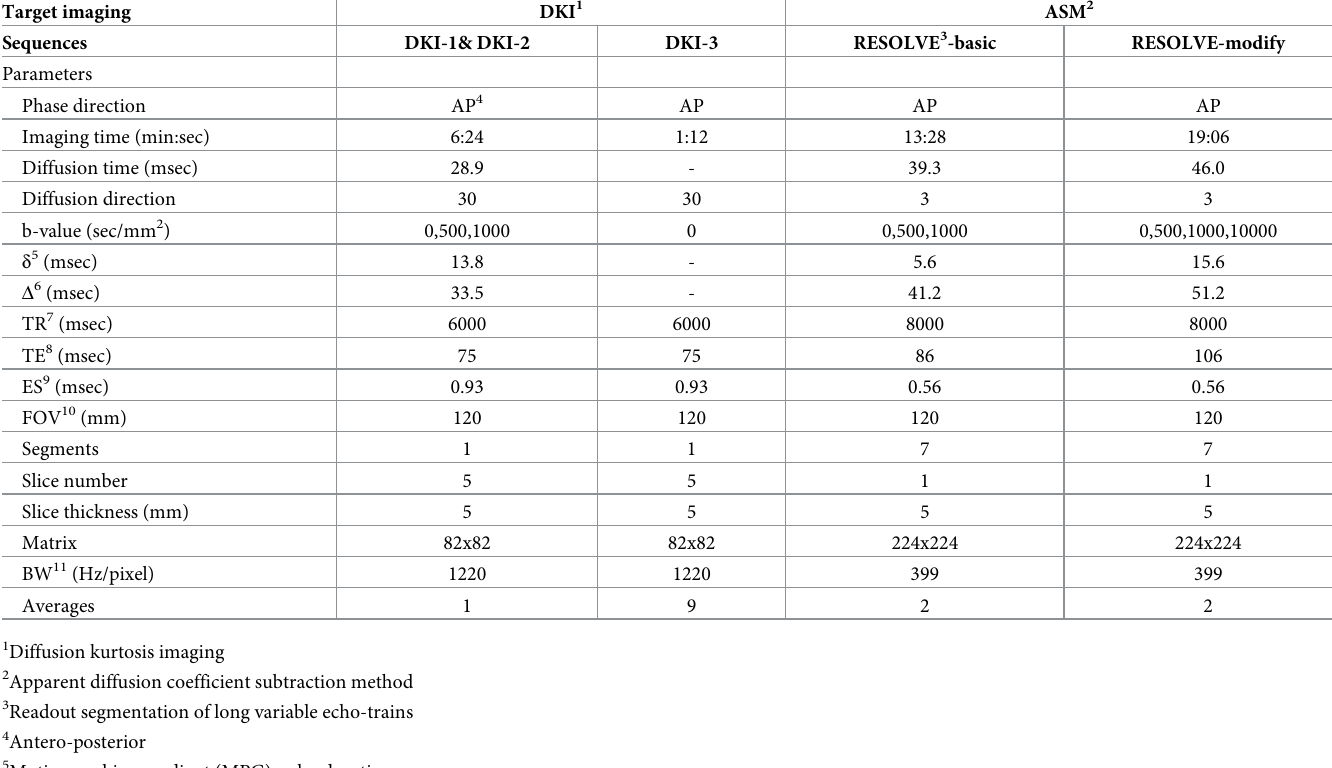
Table 1. Imaging characteristics of diffusion-weighted images for diffusion kurtosis imaging and apparent diffusion coefficient subtraction method. Target